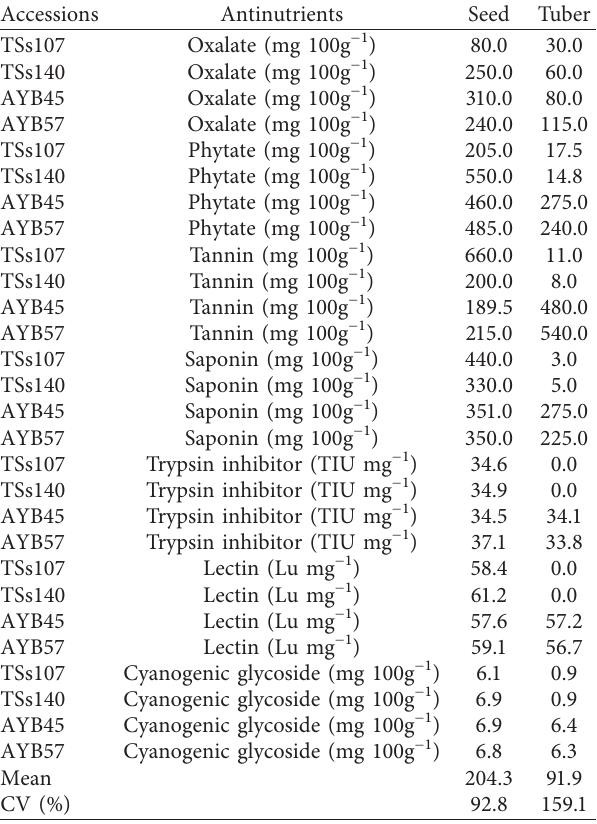
permeabilization of the intestines through its biological activities depending on the structure [43]. Elevated levels of saponin was obtained in the seeds of unprocessed AYB